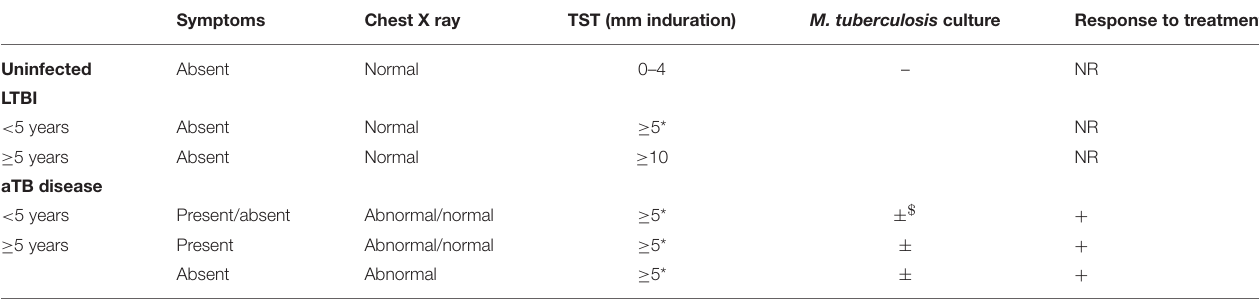
TABLE 1 | Recommended criteria in Belgium for classification of the children [adapted from